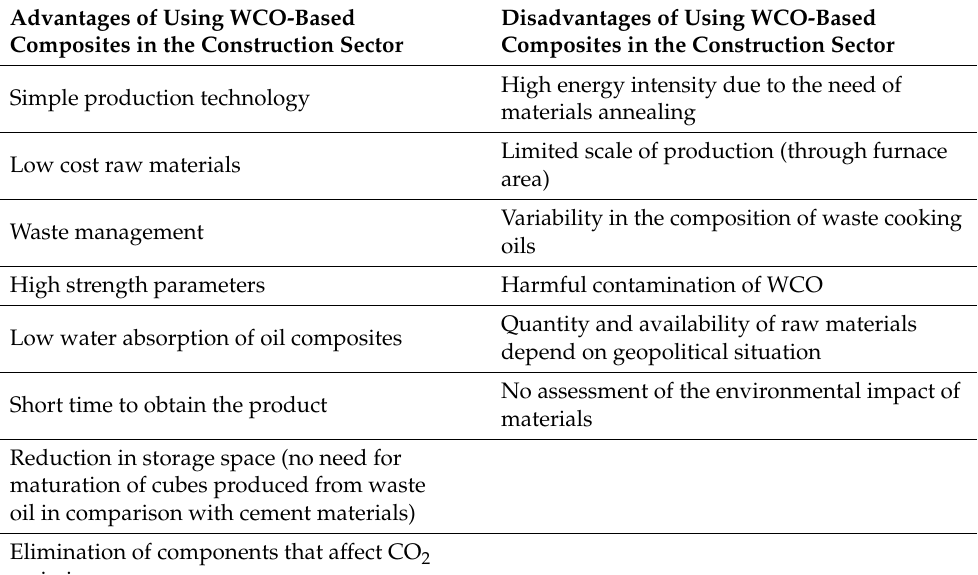
Table 1. The advantages and disadvantages of using composites based on waste cooking oil in the construction